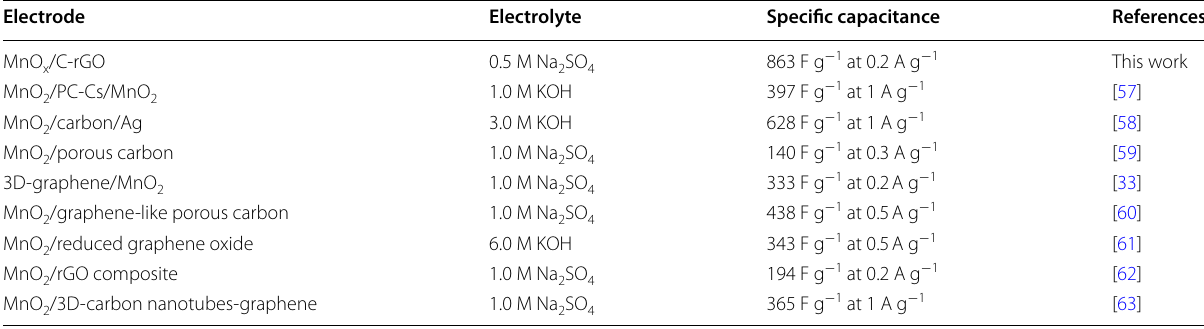
/C-rGO electrode against previously reported electrode materials for x